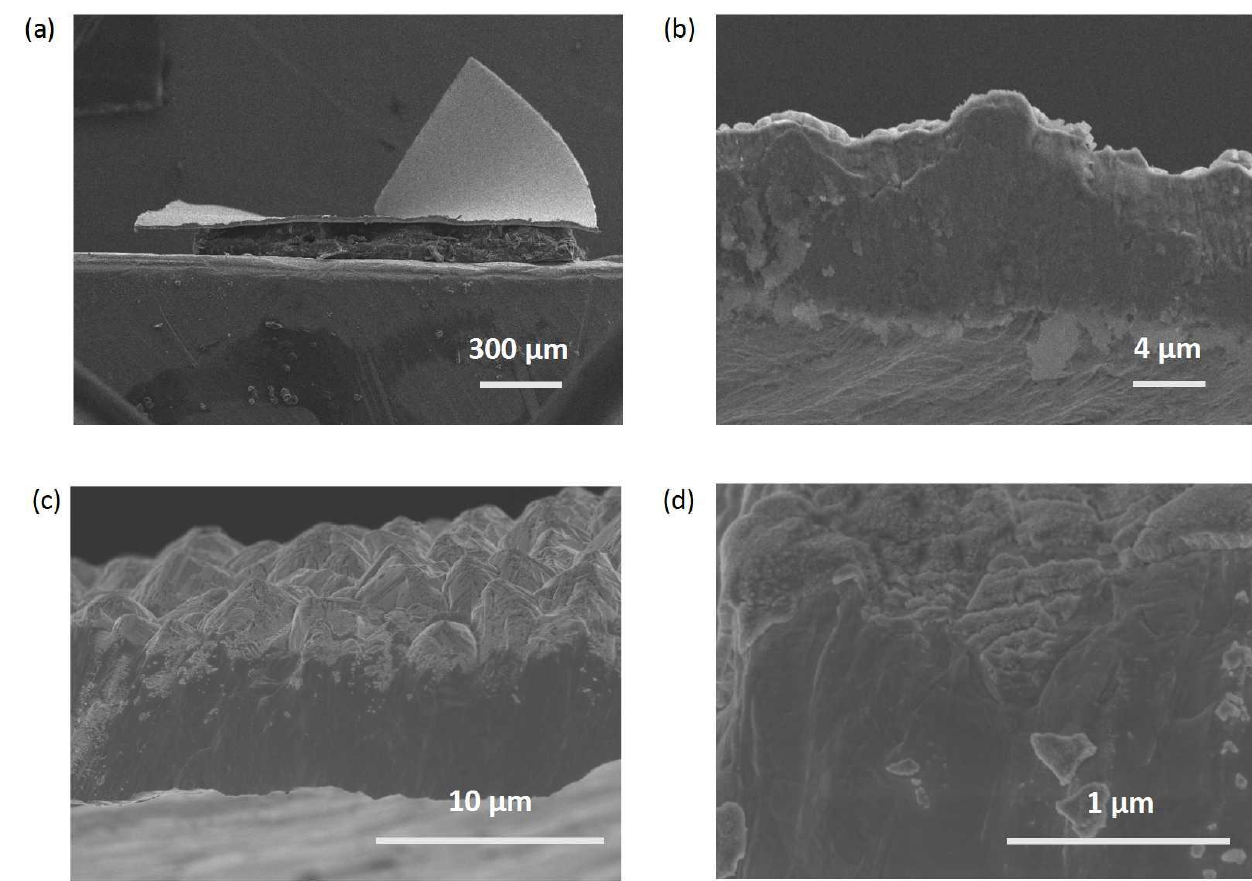
Figure 6. SEM images: ( a , b ) the transverse section of the Ge composite film with low magnification and ( c , d ) the pyramids pattern of Figure 4a with high magnification.